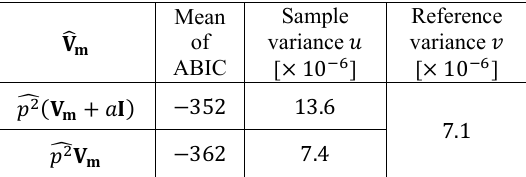
Fig. 10. Histogram of 𝛥𝑟 (when 𝐕(cid:3553) 𝐦 (cid:3404) 𝑝 (cid:2870) (cid:3554)(cid:4666)𝐕 𝐦 (cid:3397) 𝑎𝐈(cid:4667) ) Table 5. Comparison of the mean of ABIC and sample variance 𝑢 between the first and the second cases.